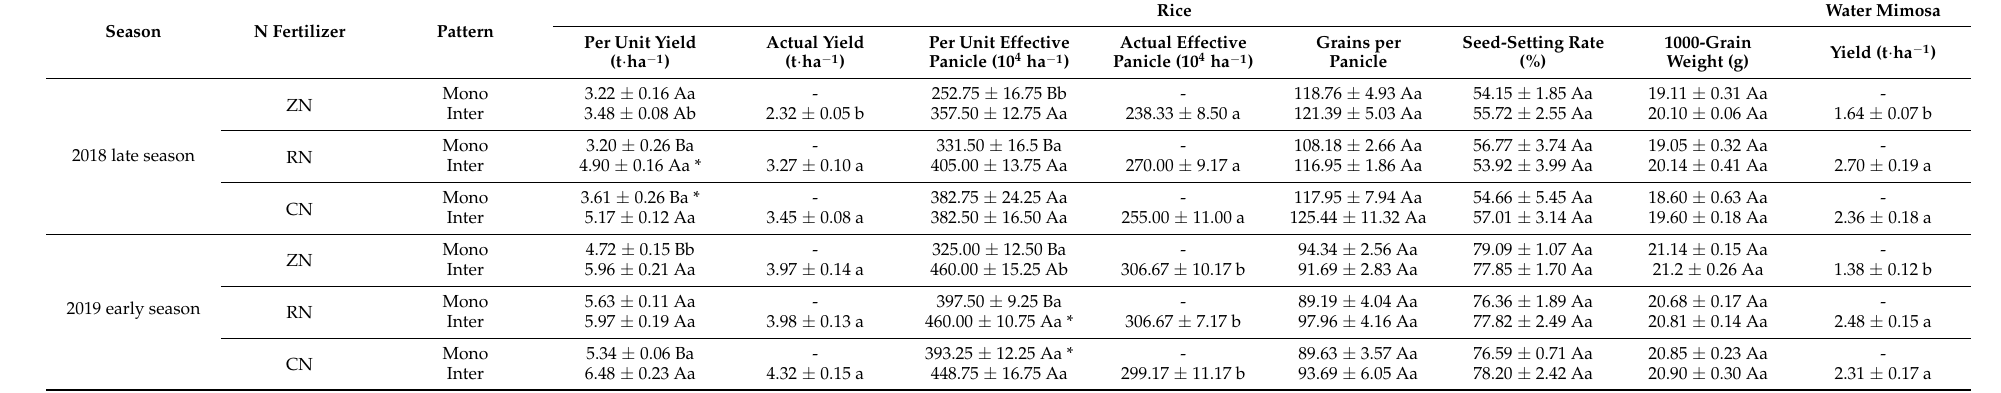
All the data presented are the means of four replicates ± standard errors. Different capital letters indicate significant differences between cultivation patterns under the same N fertilizer level ( p < 0.05). Different lowercase letters indicate significant differences between N fertilizer levels in the same cultivation pattern ( p < 0.05). Actual yield and effective panicle denote the indexes according to the area ratio of the two crops in the intercropping treatment. ZN, RN and CN indicate the 0, 140 and 180 kg ha − 1 N fertilizer levels, respectively. “Mono”and “Inter” denote the monocrop-ping and intercropping treatments. The “*” represents a significant difference between mono-cropping with the conventional N treatments and intercropping with zero and reduced N treat-ments ( p <